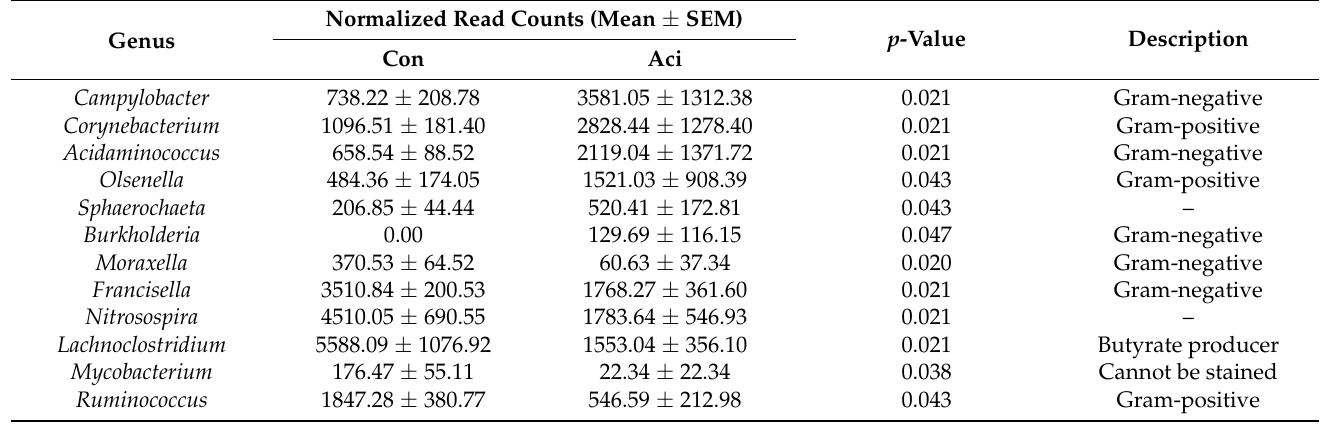
Table 1. The active bacteria changes in jejunum when using rRNA transcriptome analysis.